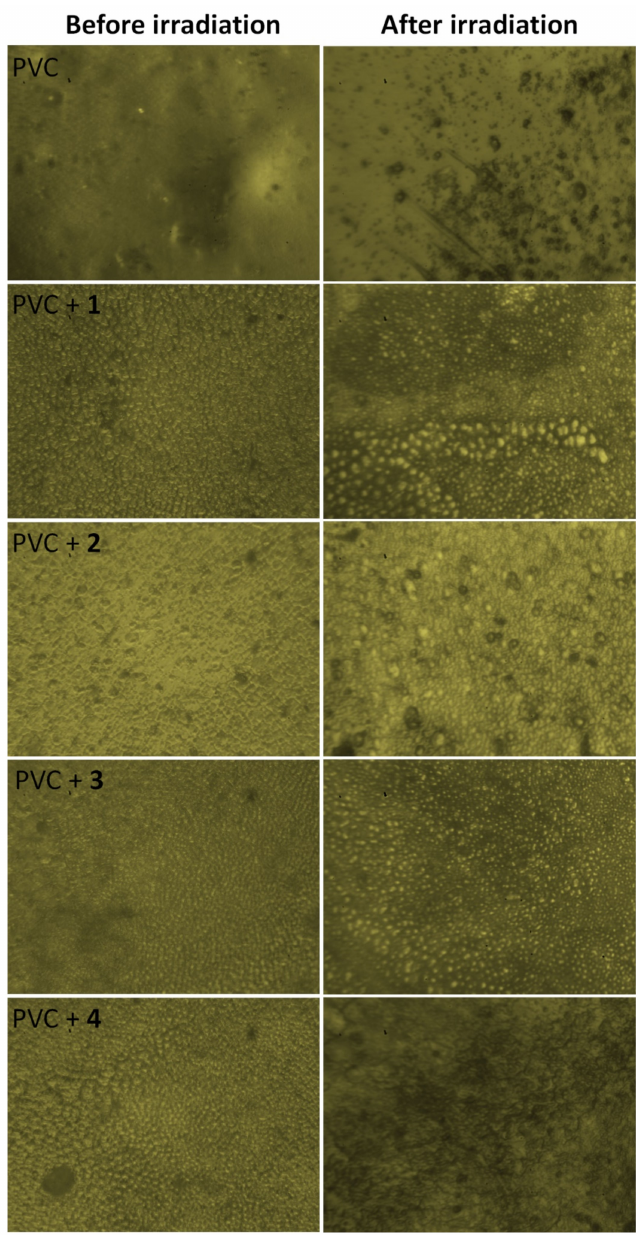
Figure 7. Microscopy images (400 × magnification) of pure and tin complex-blended PVC. The surfaces of the irradiated pure PVC and the blends were investigated further using SEM. SEM provides non-distorted, clear surface images and can record homogeneity, white spots, and the size and shape of particles [50]. The surface of the non-irradiated pure PVC film was homogeneous, smooth, and had no grooves or white spots (Figure 8a). In contrast, the SEM image for the irradiated pure PVC showed noticeable irregularity, white spots, groves, and lumps (Figure 8b), indicating a high level of photodegradation [53]. For the PVC blends containing Sn complexes of 4-methoxybenzoic acid, the surface irregularities and damage were greatly less than in the blank film (Figure 8c–f). This is consistent with the Sn complexes of 4-methoxybenzoic acid reducing the harmful effect of the released HCl on the surface of PVC. The SEM result agrees with the results from optical microscopy. The irradiated PVC films containing Sn complexes 3 and 4 showed a honeycomb-like structures. The honeycomb-like structure was clearly visible in the SEM images for the irradiated PVC + 3 film shown in Figure 9. The diameter of the pores within the PVC +